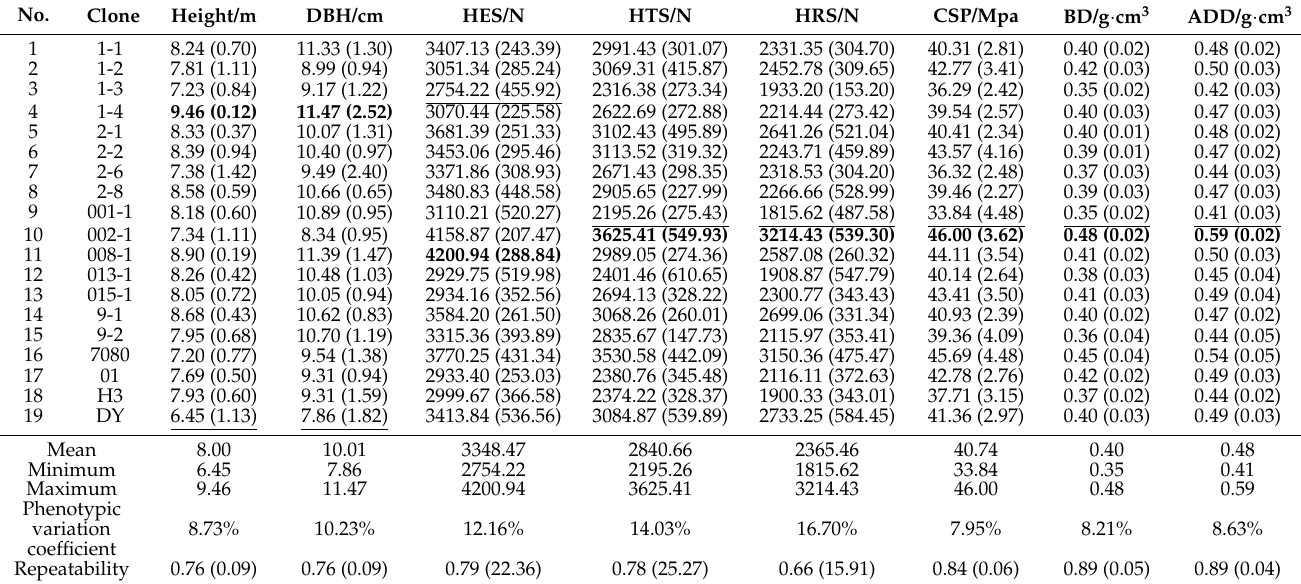
Table 4. Mean, minimum, maximum, phenotypic variation coefficient and repeatability of the traits of the